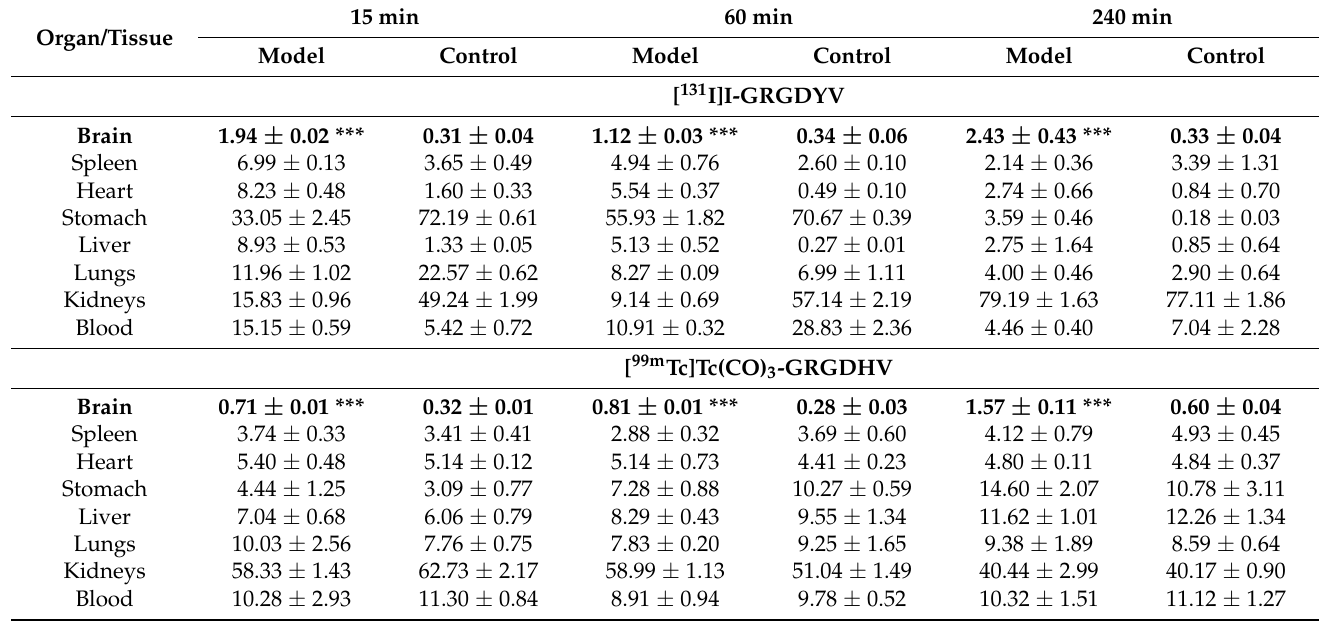
Table 1. Ex vivo biodistribution data obtained after intravenous injection of [ 131 I]I-GRGDYV and [ 99m Tc]Tc-GRGDHV into glioblastoma allograft tumor-bearing (model) and normal (control) rats ( n = 3 per group, per